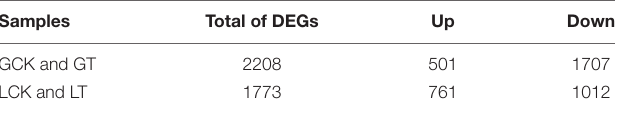
( Figure 3C and Supplementary Table 6 ). The DEMs related to proline metabolism, glutathione metabolism, and flavonoid metabolism were significantly accumulated in GCK and GT and LCK and LT. The results implied that atrazine can induce changes in antioxidant levels in millet